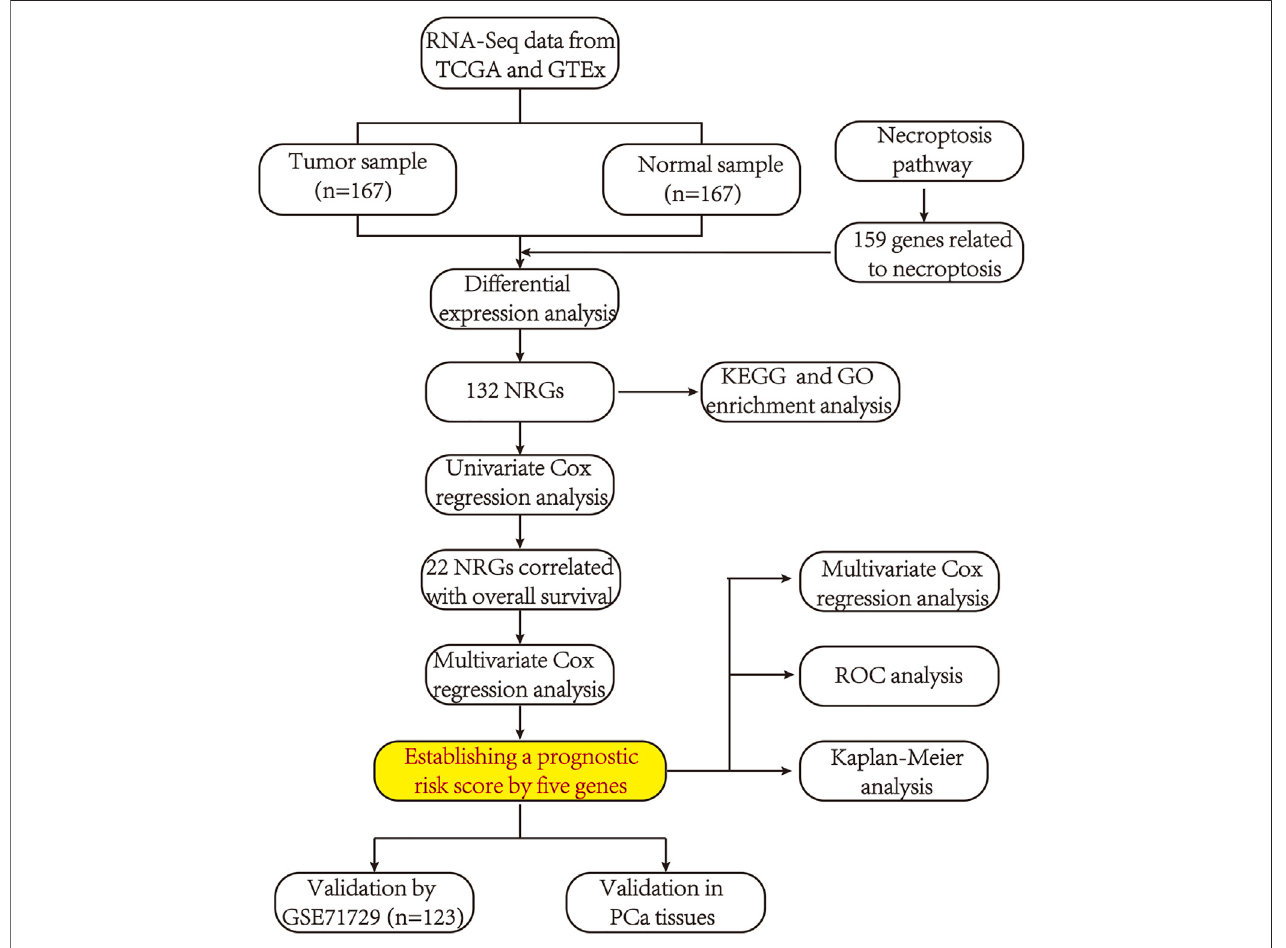
FIGURE 1 | A fl owchart showing the procedure of this